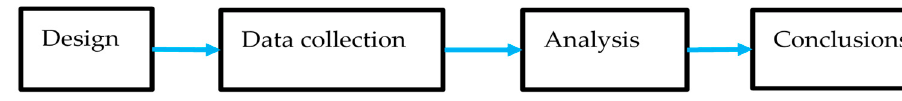
Figure 1. Steps of a case study.